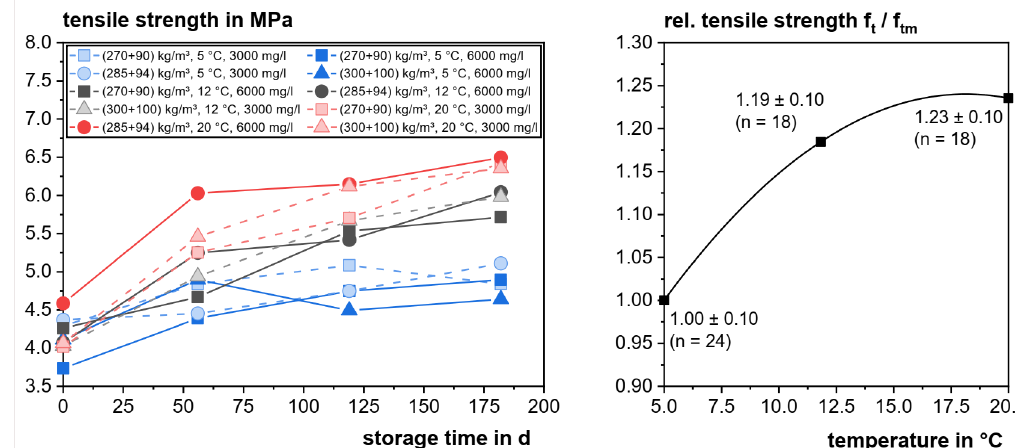
Figure 7. Tensile strength (left) and calculated regression model for the relative tensile strength (182 d, ref.: maturity function) of concrete with CEM I 42.5 N + FA and w/c eq = 0.45 after storage in Na 2 SO 4